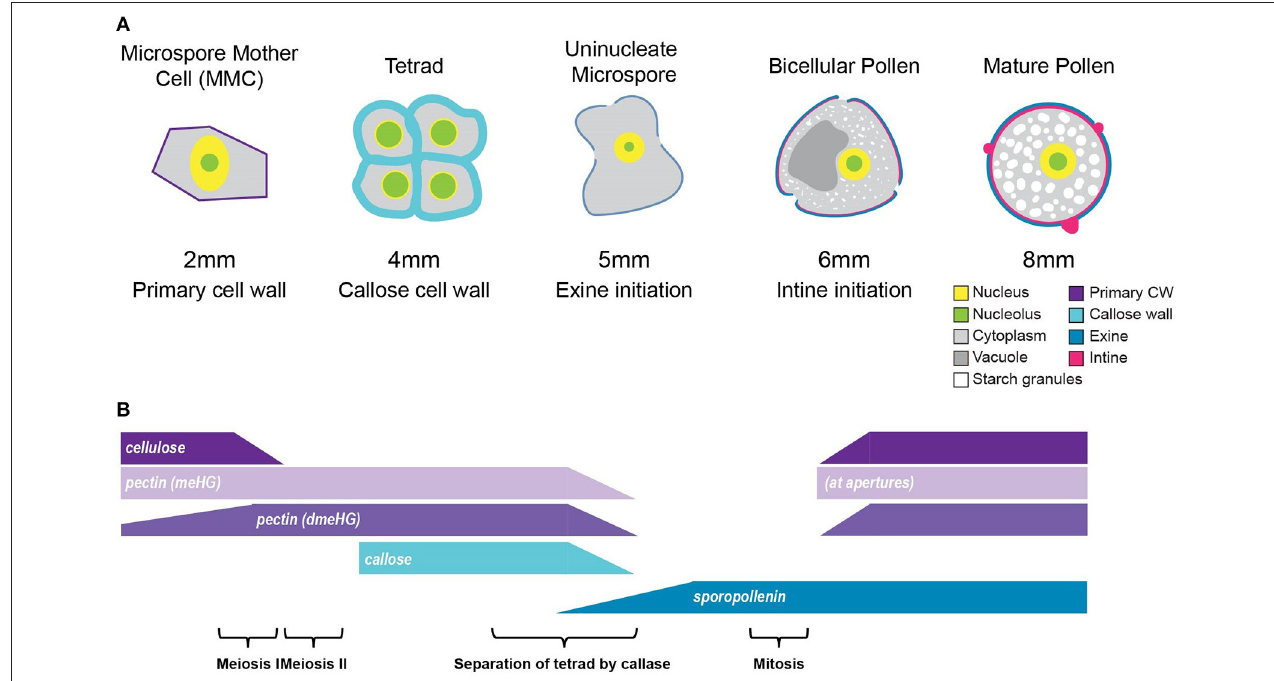
FIGURE 9 | Summary of tomato pollen wall development process. (A) A graphic summary of the major hallmarks of the tomato pollen development timeline. The pollen development stage is given above, and the bud length corresponding to each stage is given below, along with the major cell wall identities. (B) Cell wall polymer changes during development. The cellulose of the primary cell wall of the MMC breaks down at the 2-mm bud stage. Following meiosis, the tetrad cells are surrounded by a thick callose and pectin wall, which is broken down to separate the tetrad cells into free uninucleate microspores. Exine deposition by the tapetal cells begins at the 5-mm bud stage and continues through pollen maturation. The deposition of the cellulose and pectin, which make up the intine, initiates at the 6-mm bud stage and also continues through maturation. meHG deposition at the bicellular pollen stage is initially limited to the aperture regions, later spreading to the whole